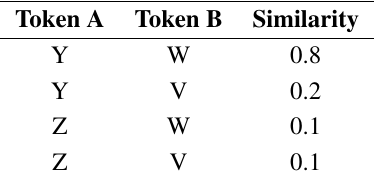
Table 5. Word pair similarity scores for semantic dissimilarity function example. Token A Token